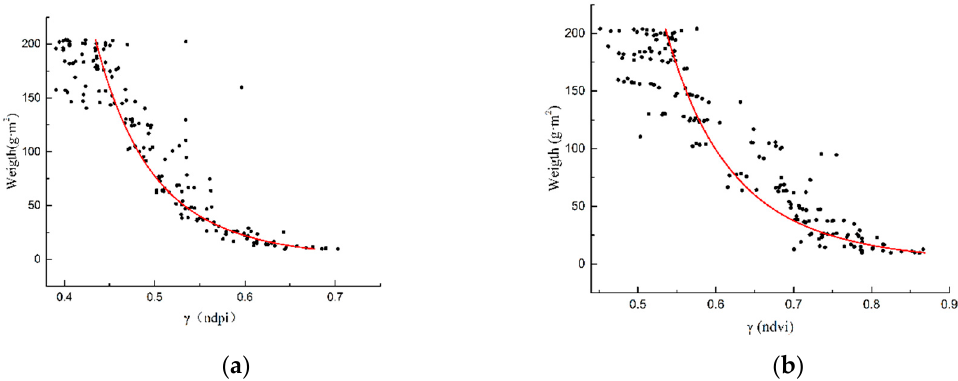
Figure 7. Inversion models based on ( a ) normalized di ff erence phenology index (NDPI) and ( b ) normalized di ff erence vegetation index (NDVI).